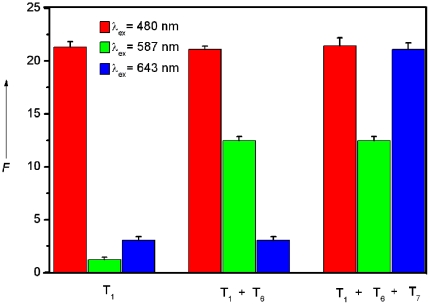
Multiplex DNA detection.Fluorescence intensity histograms of the probe mixture ([PHIV] = [PHBV] = [PK167] = 50 nM) toward different target combinations in the presence of PMPD nanorods under excitation/emission wavelengths of 480/522, 587/601, and 643/660 nm/nm. All measurements were done in Tris-HCl buffer in the presence of 5 mM Mg2+ (pH: 7.4). 10-µL PMPD nanorods were used in each measurement.